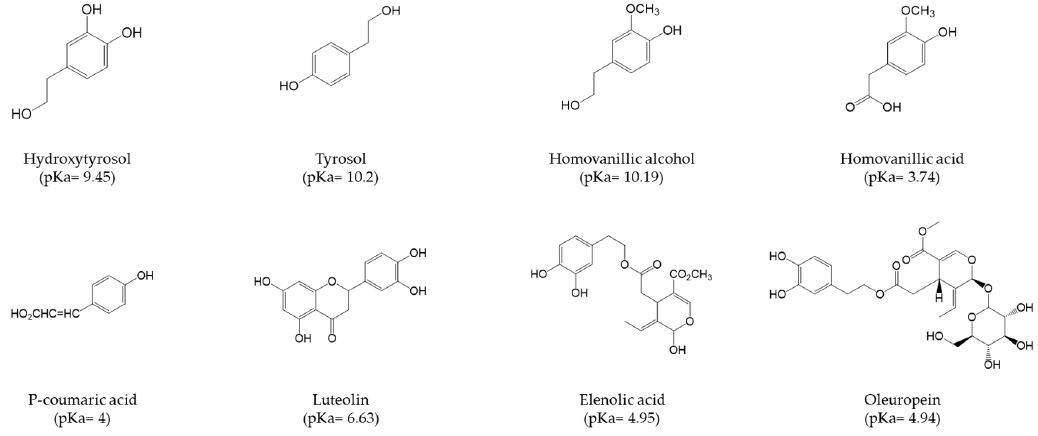
Figure 3. The major constituents of OMW. The common name and the pKa value are reported under each compound. each